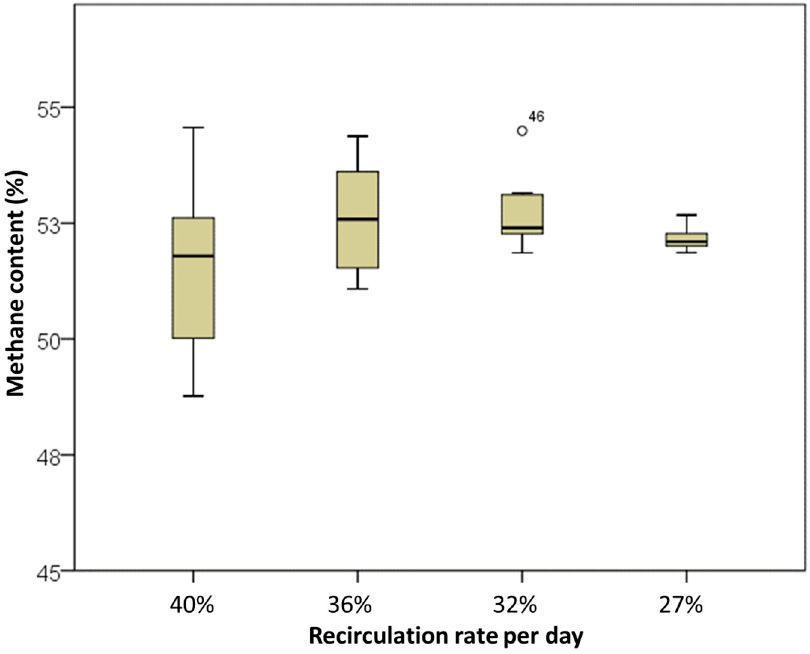
Figure 5. Methane content in the biogas as a function of recirculation rate ( p < 0.05).